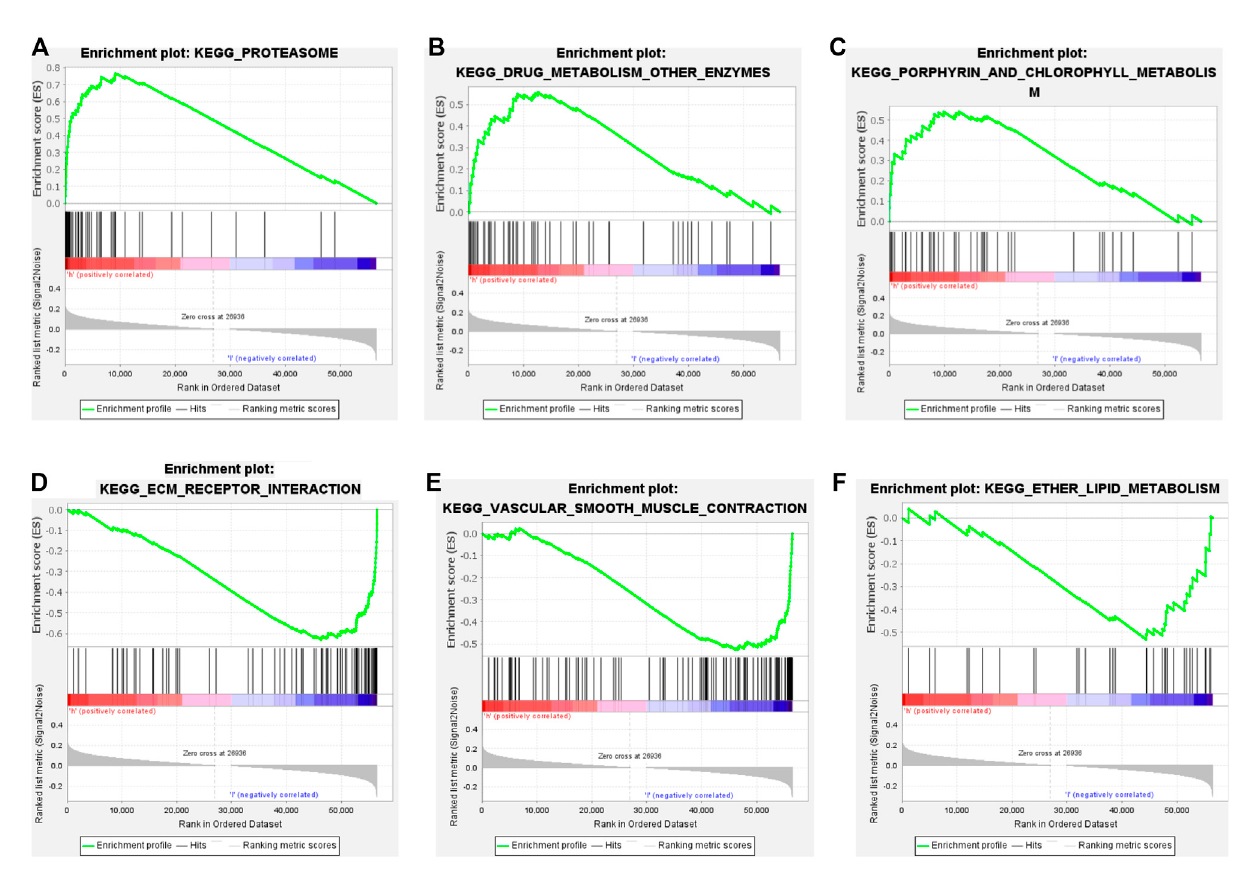
FIGURE3| Geneset enrichmentanalysisGSEA withhigh and lowTMBgroups. (A – C) The top3pathway axisenriched inhigh TMBgroups included proteasome, drug metabolism other enzymes, porphyrin and chlorophyll metabolism. (D – F) The top3 pathway axis enriched in low TMB groups were ECM receptor interaction, vascular smooth muscle contraction, and ether lipid